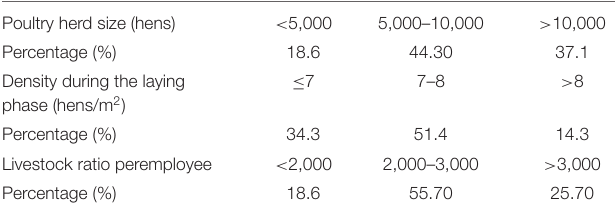
TABLE 1 | Characteristics of 70 poultry farms